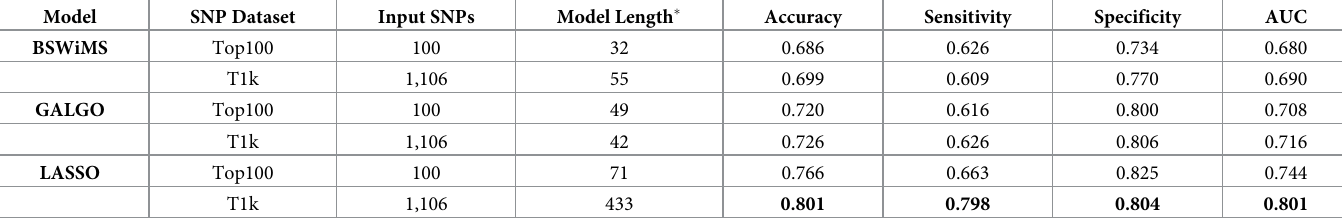
number of SNPs used from 433 to 493. The second method consisted of mixing the SNPs selected in both models as the input to LASSO and the internal cross-validation. Thus, the input included 482 SNPs (433 from the T1k model of Table 1 plus 49 SNPs from the Missed (test) model of Table 2) also using the UnrADS samples. Fig 5C and Table 2 (first row Models Mix ) demonstrate that the AUC increased from 0.801 to 0.842. Moreover, the model decreased the total number of SNPs needed from 433 to 358 (S7 Table). This result suggests that SNPs Table 1. Summary of model building for all methods